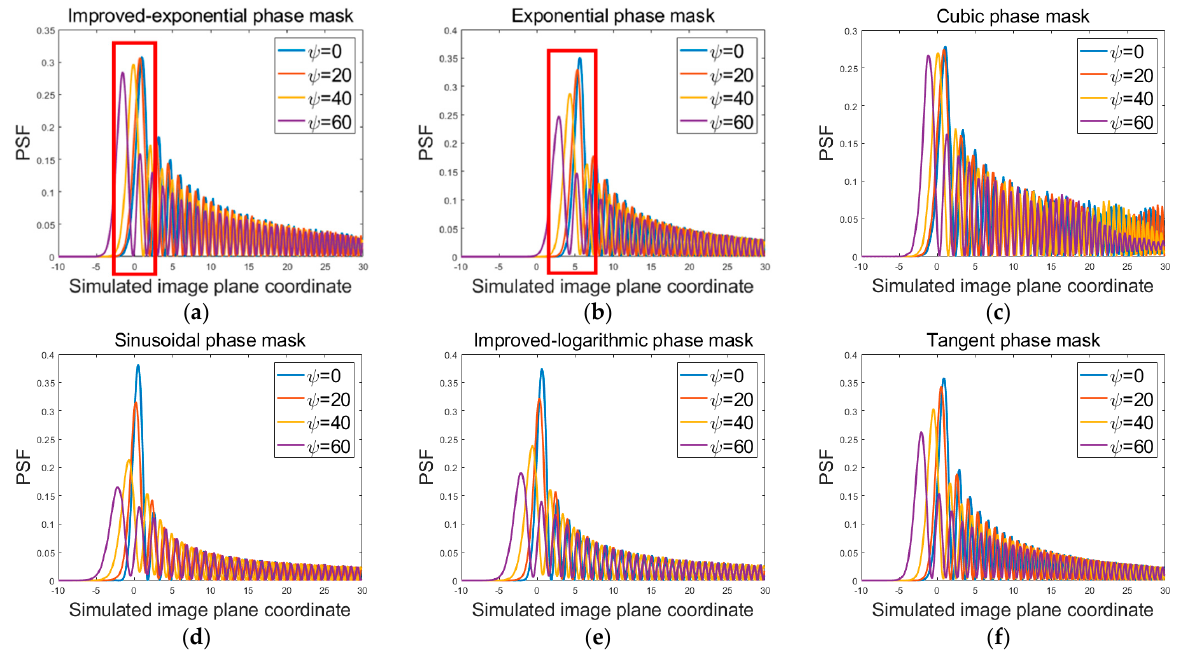
Figure 8. Defocusing PSF curves of six kinds of phase mask ( a ) Improved exponential phase mask ( b ) Exponential phase mask ( c ) Cubic phase mask ( d ) Sinusoidal phase mask ( e ) Improved logarithmic phase mask ( f ) Tangent phase